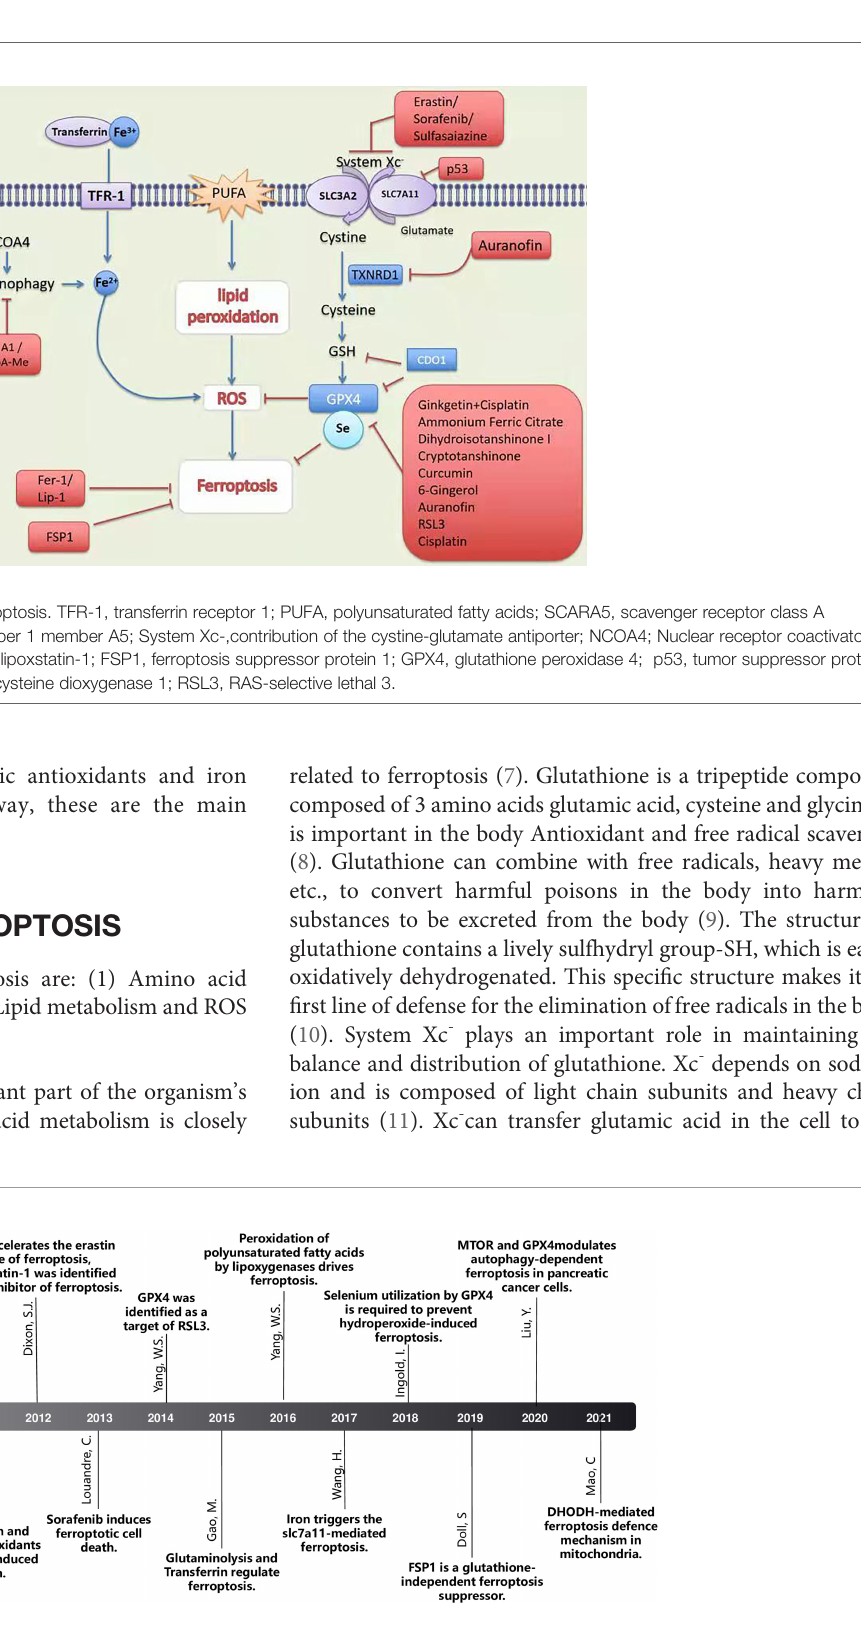
FIGURE 2 | The milestone of